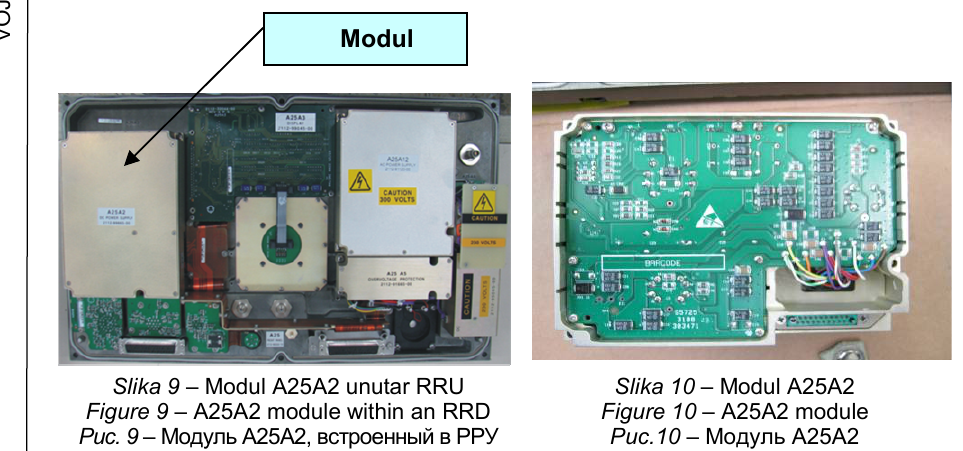
Рис . 9 – Модуль A25A2, встроенный в РРУ Рис .10 – Модуль A25A2